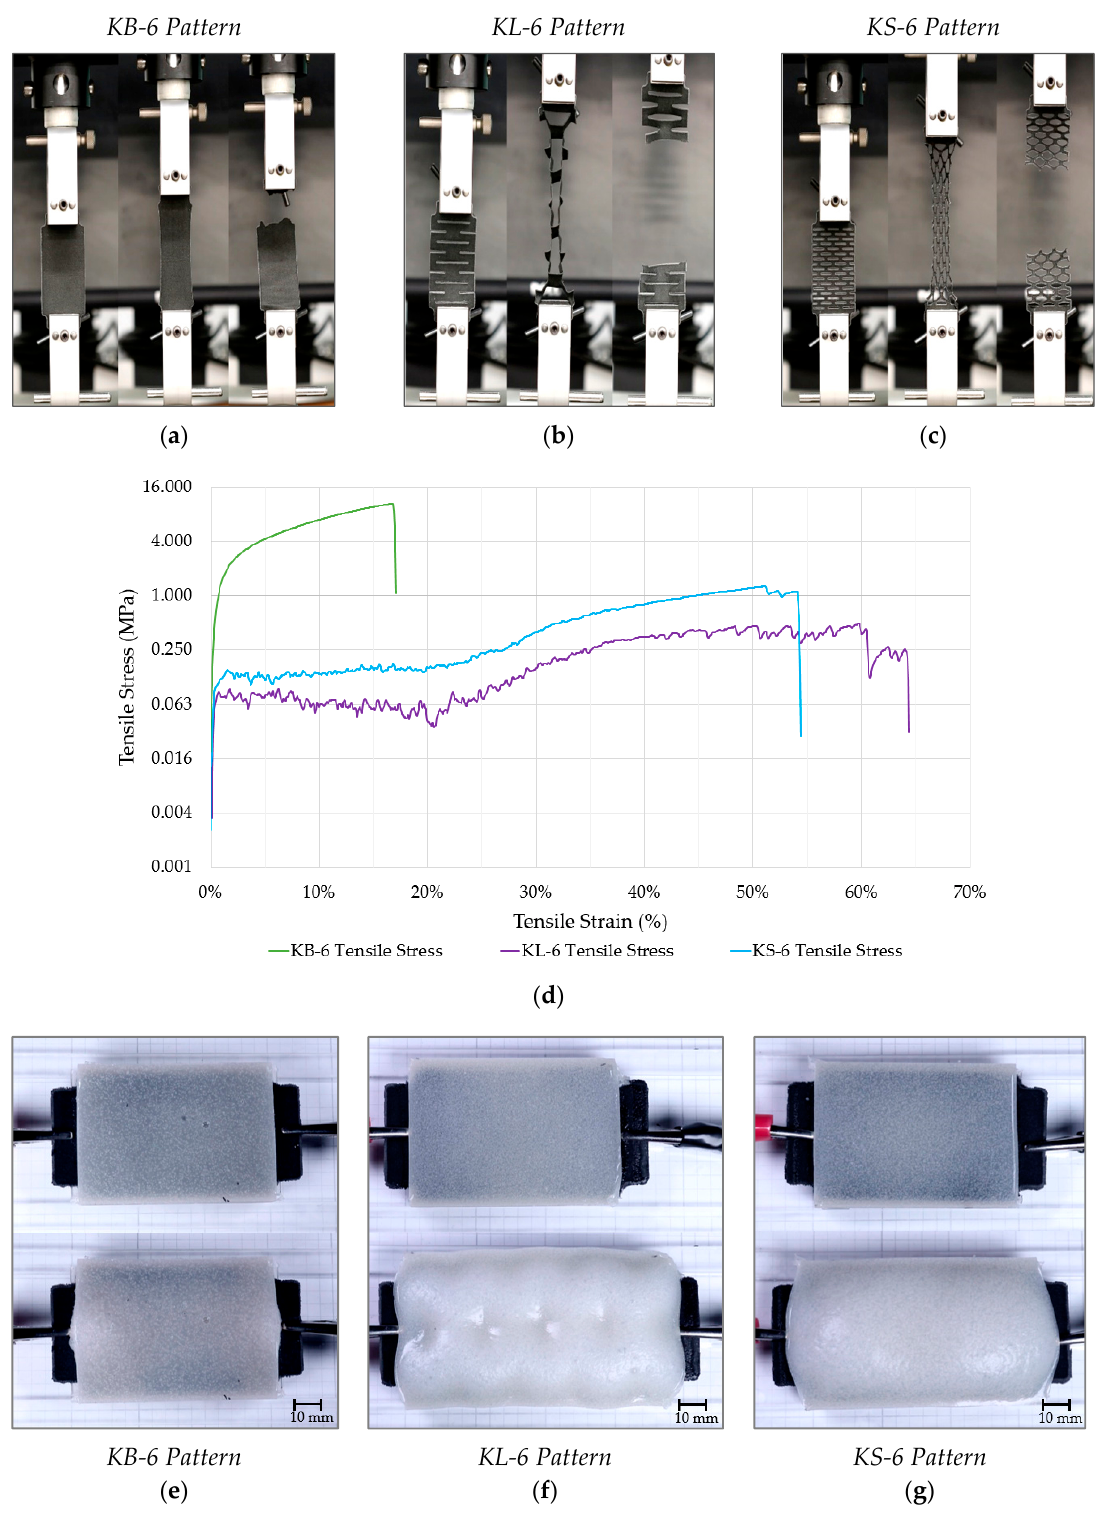
Figure 9. Mechanical testing. Tensile test pictures of the fabrics at initial condition, maximum extension, and failure, from left to right. ( a ) KB-6; ( b ) KL-6; ( c ) KS-6. Tensile test results. ( d ) Engineering tensile strain vs. engineering tensile stress in Thermionyx fabric designs. For the KL-6 and KS-6, one can see the points at which the smaller sections of the fabric snap apart towards the upper limits of the strain. Silicone-ethanol actuator actuation. Top Image: Initial condition. Bottom Image: Maximum extension. Each square on the grid paper represents 5 mm. ( e ) KB-6; ( f ) KL-6; ( g ) KS-6.